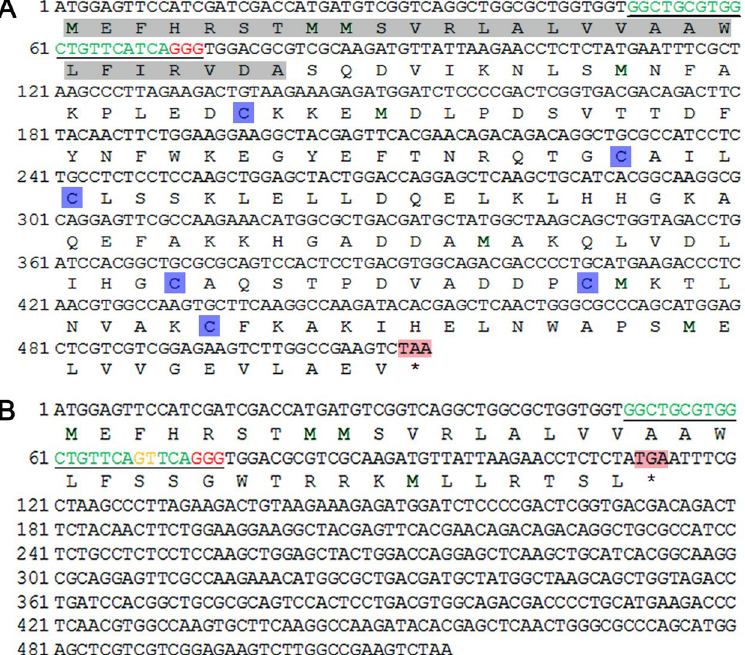
Figure 3. Nucleotide and deduced amino acid sequences of wild type PBP1 ( A ) and the mutant PBP1 in # 8 single pair moths of G1 generation ( B ) in H. armigera . The target site (in green) and the PAM sequence (in red) are underlined. The first 27 amino acids are signal peptide. The letter with blue shadow is the 6 conserved cysteines. The sequece in orange letter in the target site indicates the insertion, which resulting in a stop codon close the target site. The asterisks indicates stop codons.